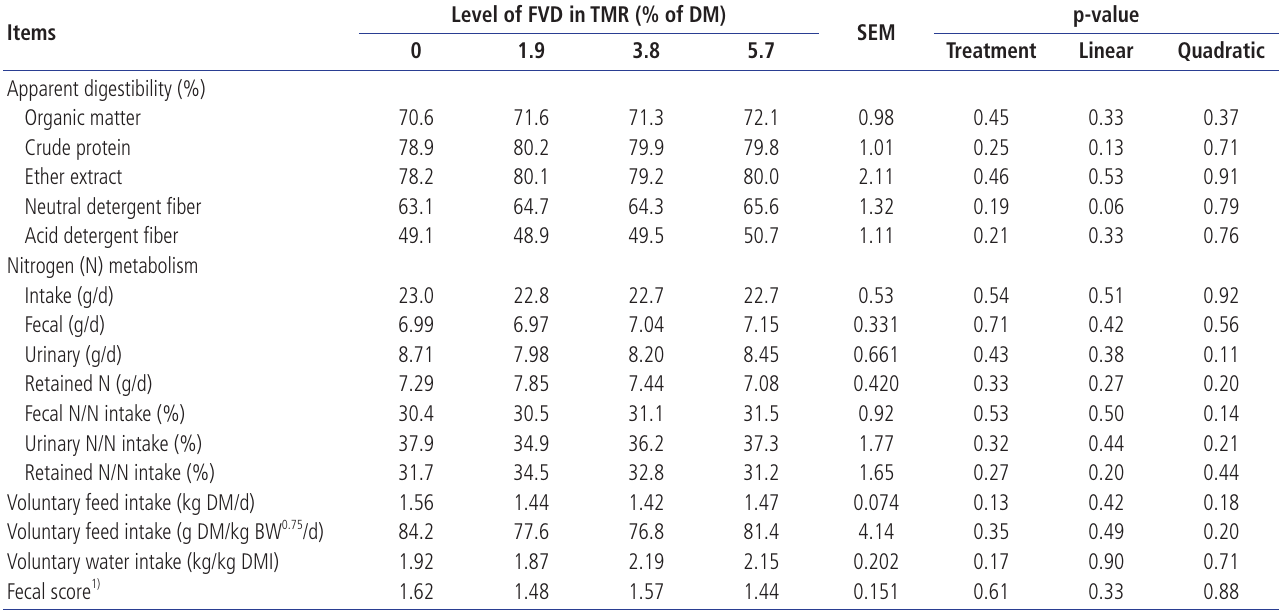
Level of FVD in TMR (% of DM)